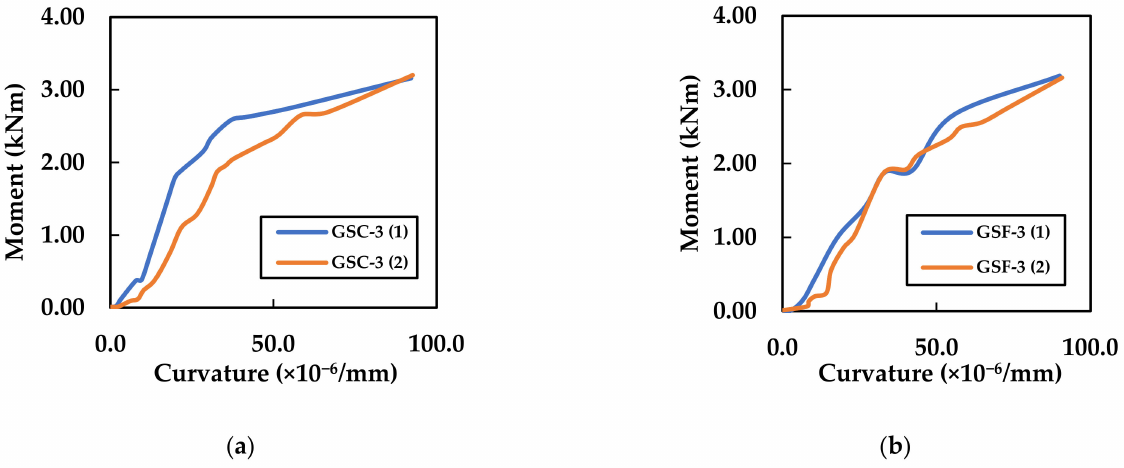
Figure 17. Moment–curvature behaviour of ( a ) GSC-3 and ( b ) GSF-3.